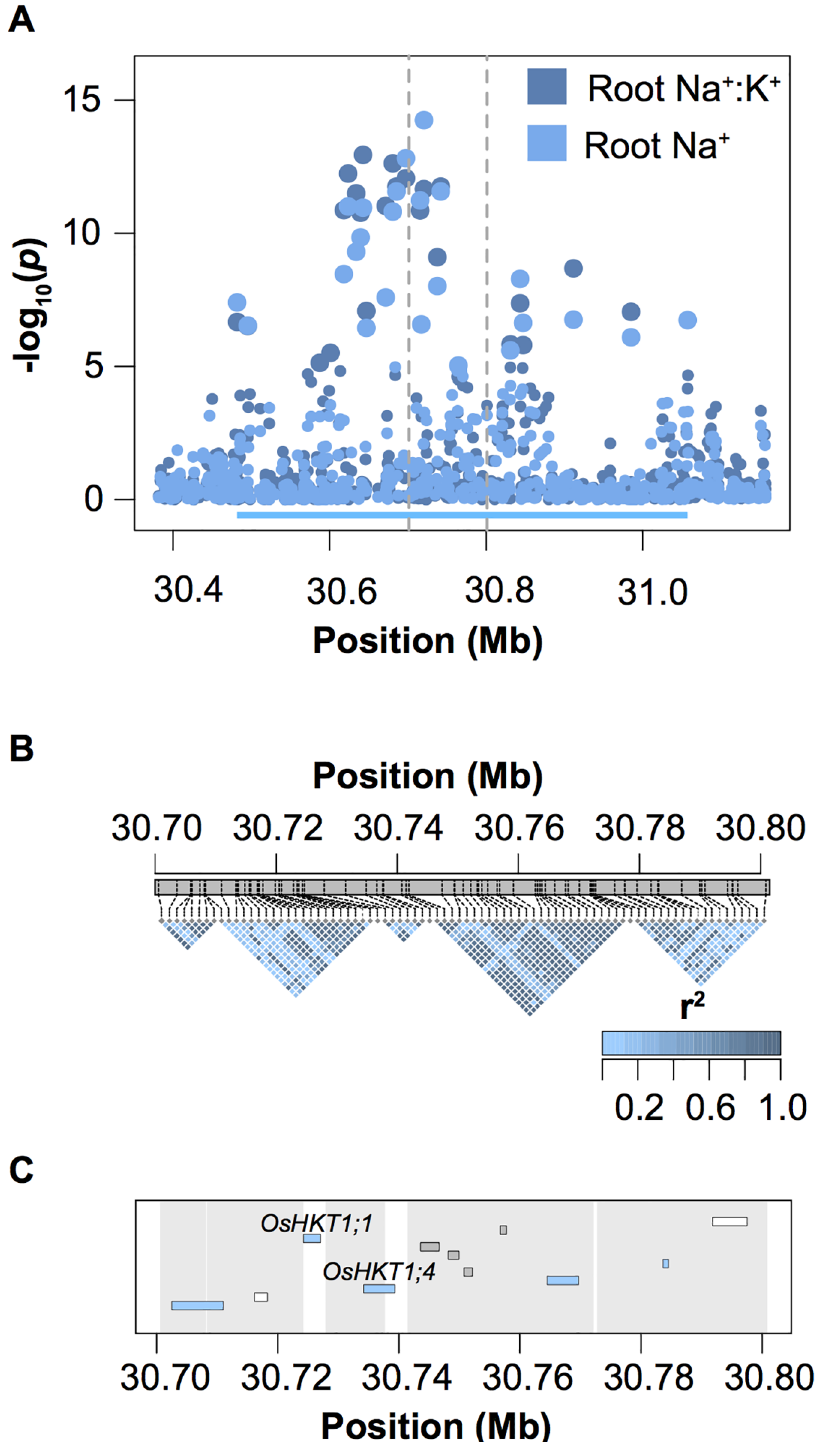
Fig 3. Genetic characterization of RNC4 . (A) Regionalmanhattanplot summarizingGWA analysisof root Na + androot Na +: K + . The regiondefining RNC4 is indicatedwith the cyanbar.(B) LD plotsfor a subsetof five haplotype blockswithin RNC4 .The verticalbrokengray linesinA indicatethe regioncharacterizedby haplotype blocks.The genespresentin this regionare illustrated in C. Genesencodingtransposableelementsare highlighted in the genetrack in gray, whilethoseencodingexpressedproteinsare highlightedin white.The regionsdefinedby eachblockare indicated in gray.